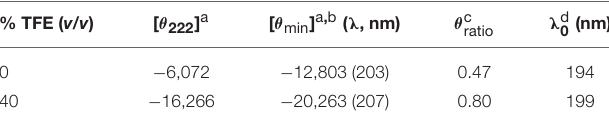
TABLE 1 | Far-UV region CD parameters of Mn-MC6 * a in phosphate buffer/TFE solution pH